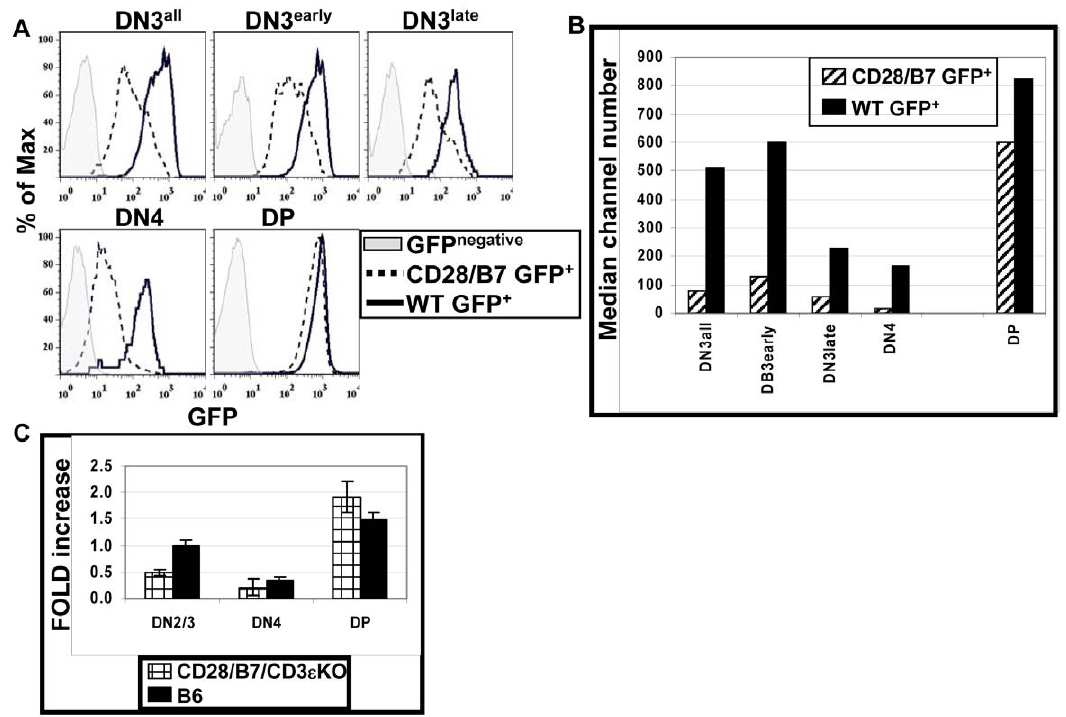
Figure 5. CD28/B7-dependent development suppresses RAG2 expression in DN but not DP cells. (A) Histograms show GFP + (RAG2) staining on the FCM gated cell populations from WT GFP + (solid line) or CD28/B7 GFP + (dashed line) mice. Gates used to identify early and late DN3 subsets are as described in Figure 1B. The grey filled histograms show FL1 staining of the indicated DP and DN subsets analyzed from GFP 2 mice. (B) This graph depicts the median channel number of GFP + cells shown in panel (A) and is representative of three experiments performed. (C) This graph summarizes real-time PCR quantification of RAG2 expression in FCM-sorted DN2/3, DN4 and DP cells from B6 and CD28/B7/CD3 e KO thymi. RNA was prepared and cDNA was synthesized as described in Materials and Methods. RAG2 cDNA was amplified using SABiosciences RT 2 qPCR primers. RAG2 expression was normalized against b -actin expression. Real-time analysis was performed on three independent cDNA samples for each genotype. Data are expressed as mean fold increase 6 SE relative to B6 DN2/3